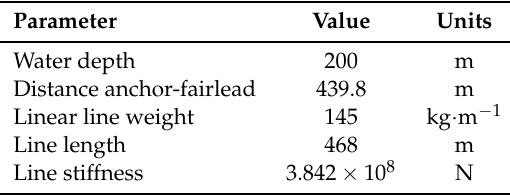
Table 5. Main characteristics of the UMaine-Hywind mooring system implemented in ANSYS R (cid:13) AQWA.